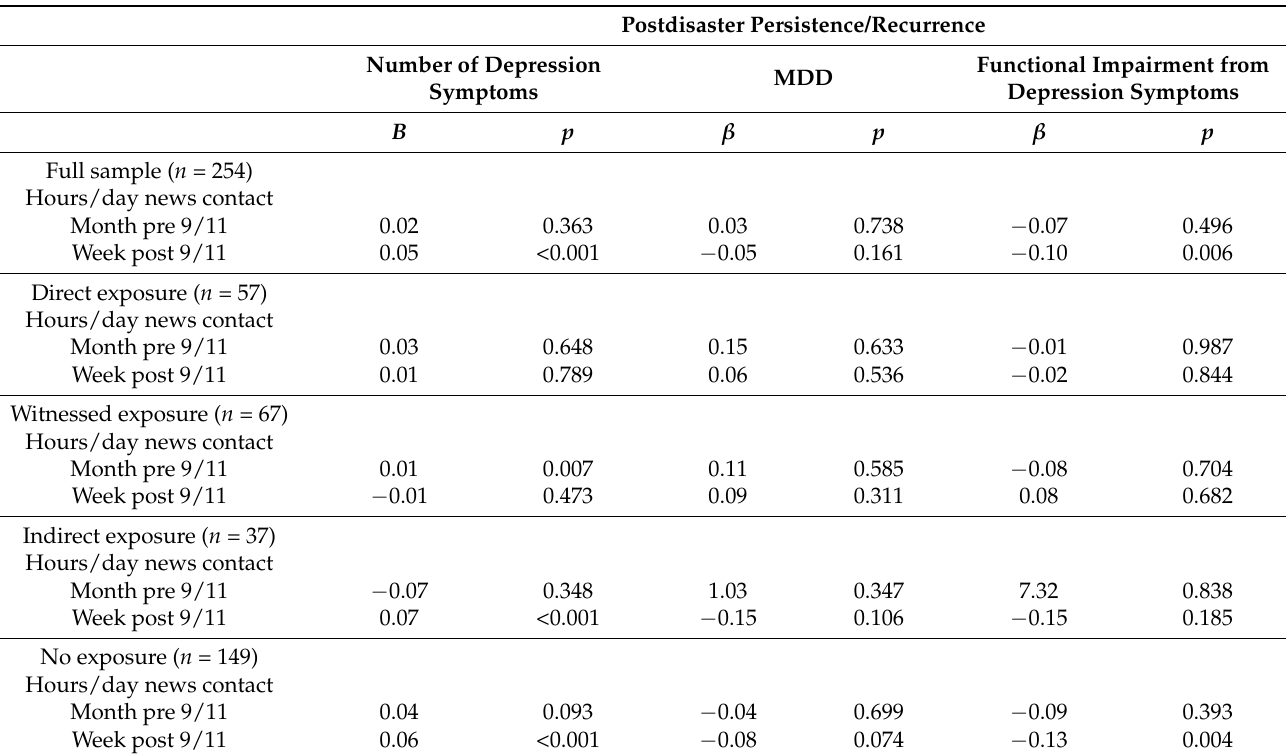
Table 2. Results from poisson and logistic regression analyses for postdisaster depression variables.